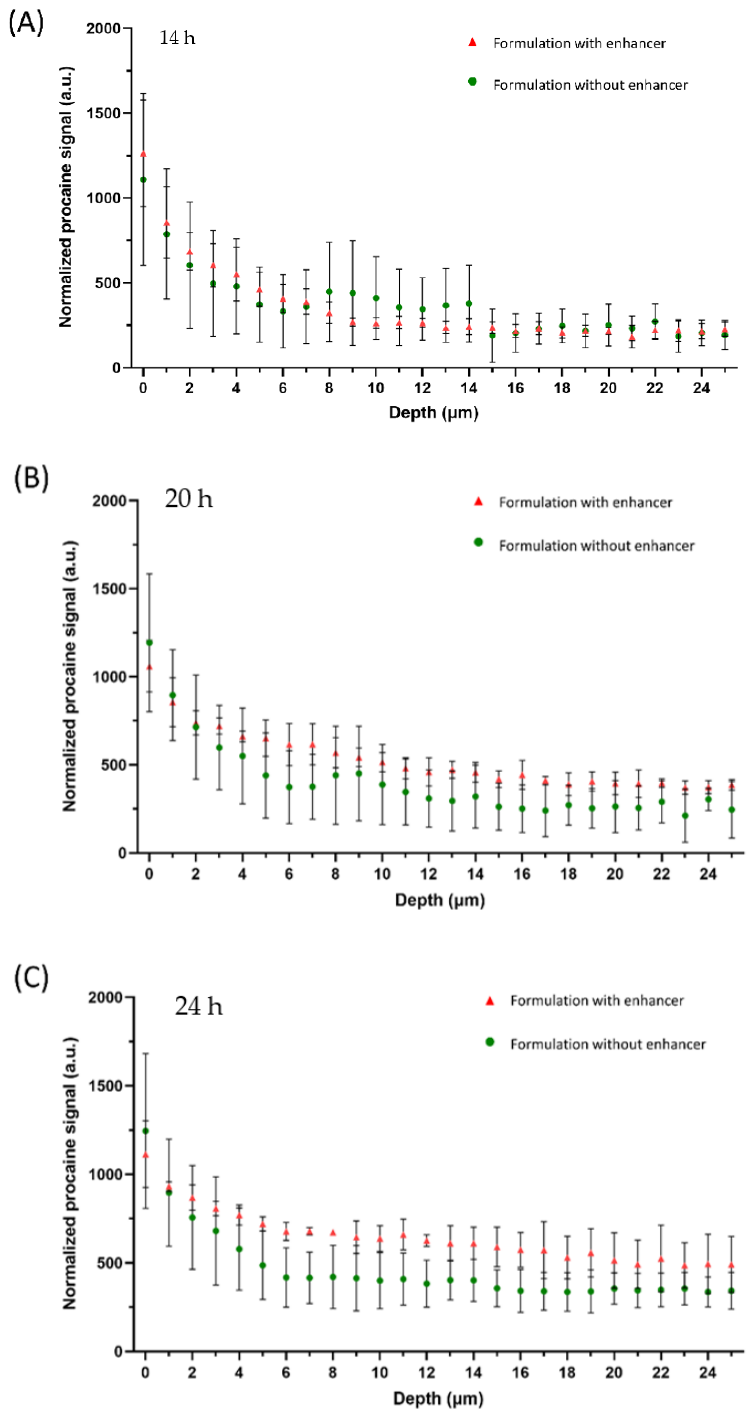
Figure 5. Penetration profiles of procaine HCl in porcine skin after the skin incubation time of 14 h ( A ), 20 h ( B ) and 24 h ( C ) with the measurements of the in-line device. Two procaine-HCl containing formulations were compared: formulation with enhancer (red triangles) and without enhancer (green circles). Mean ± SD ( n ≥ 9).